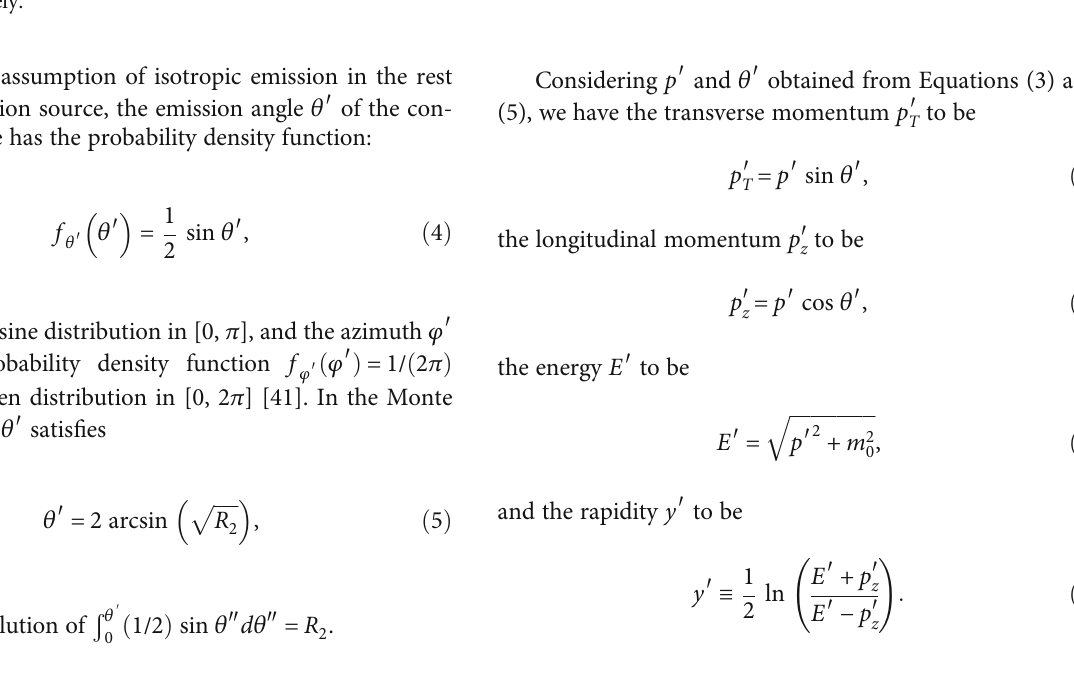
Figure 4: Same as Figure 1 but showing the spectra of K + . Panels (a – f) represent the spectra for z = 0 – 18, 18 – 36, 36 – 54, 54 – 72, 72 – 90, and 90cm,